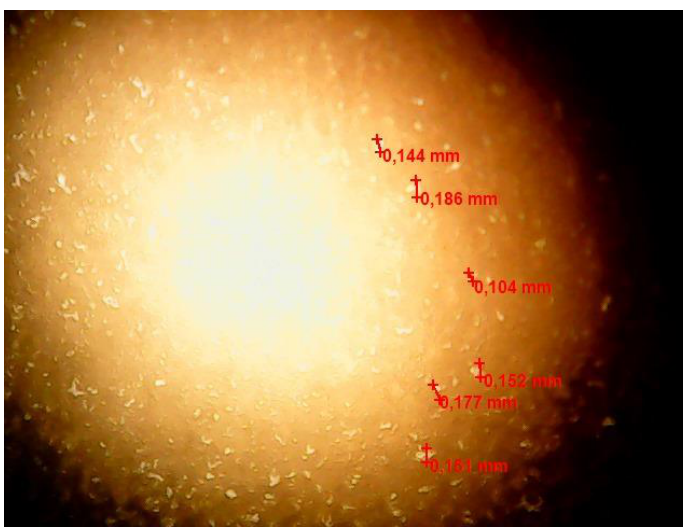
Figure 4. Optical microscopic image of a freshly prepared w/o emulsion sample.